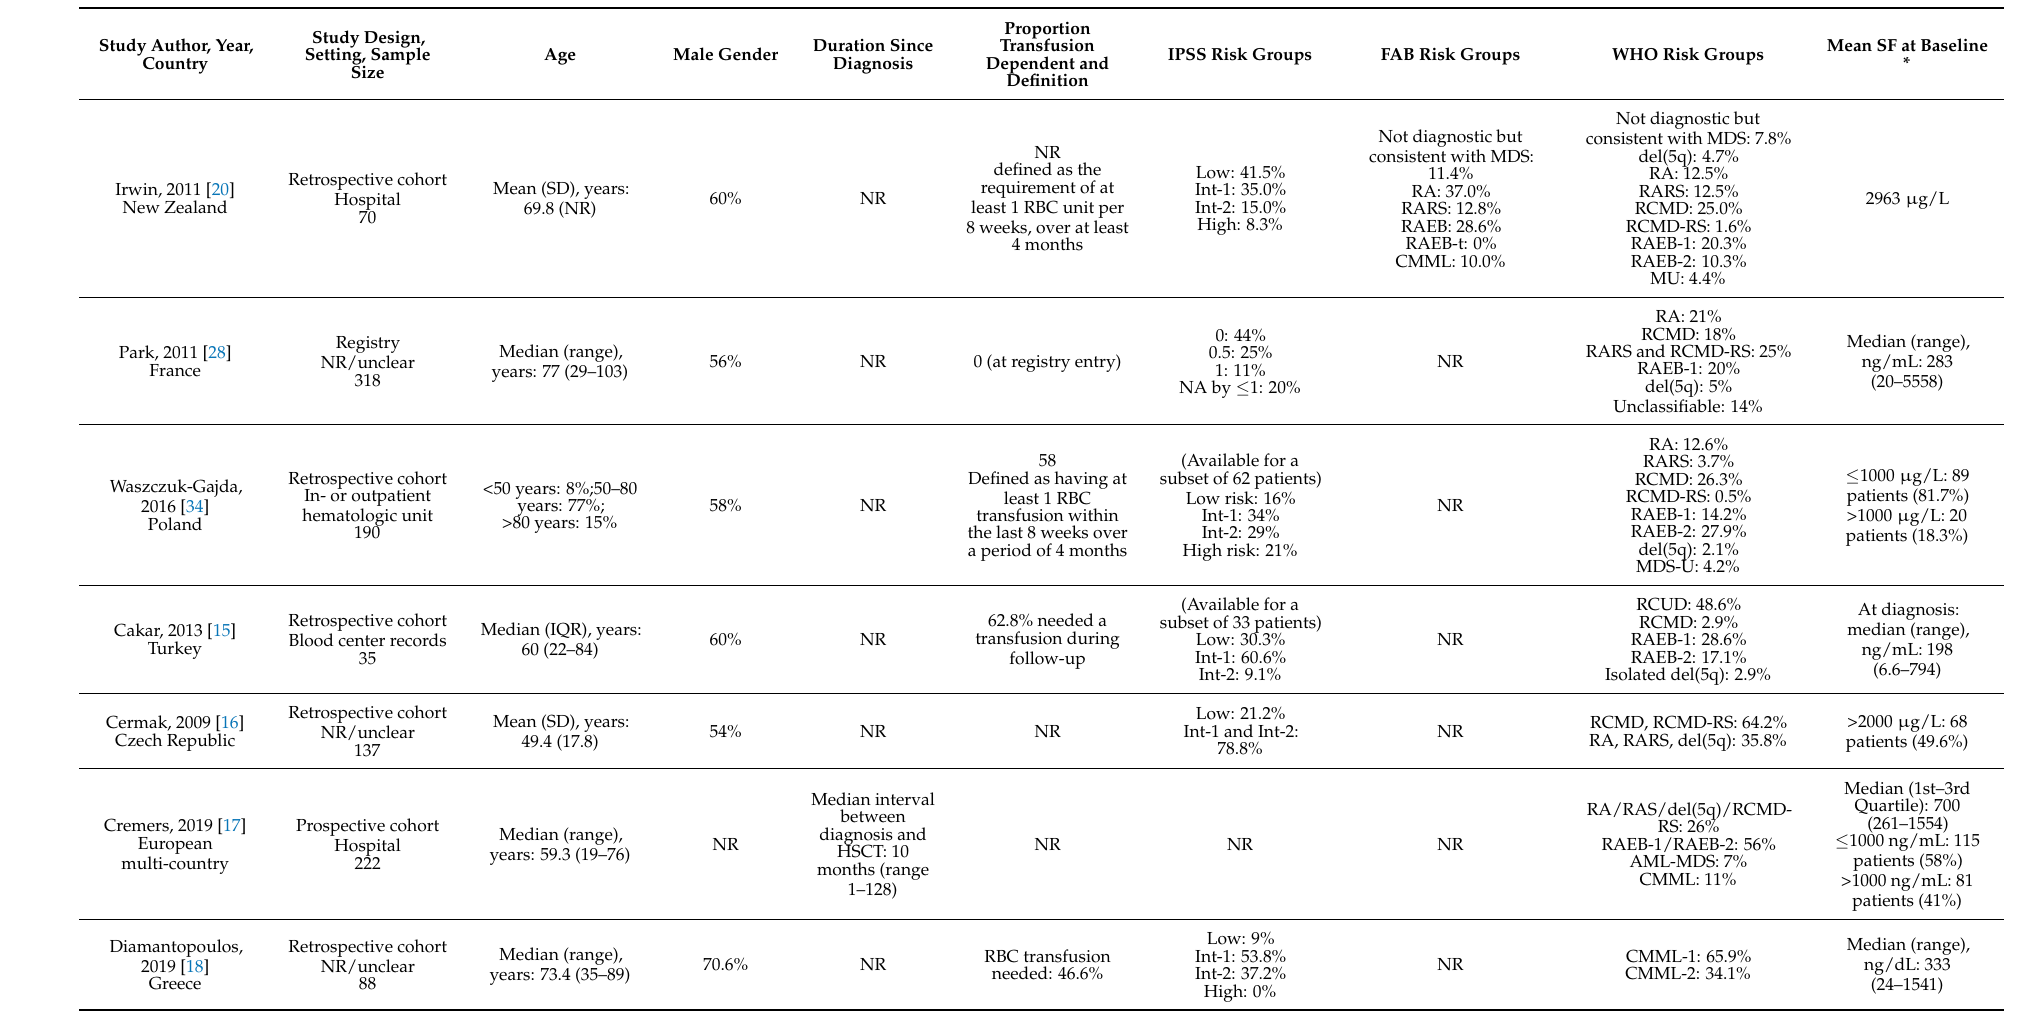
Table 2. Patient characteristics of